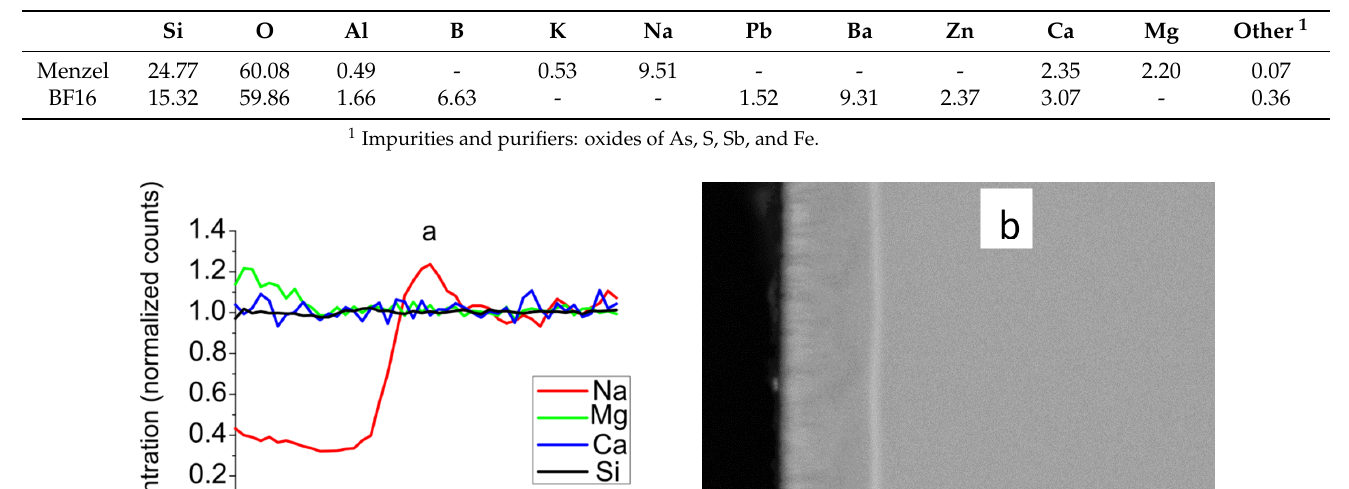
Table 1. Atomic composition of studied glasses.